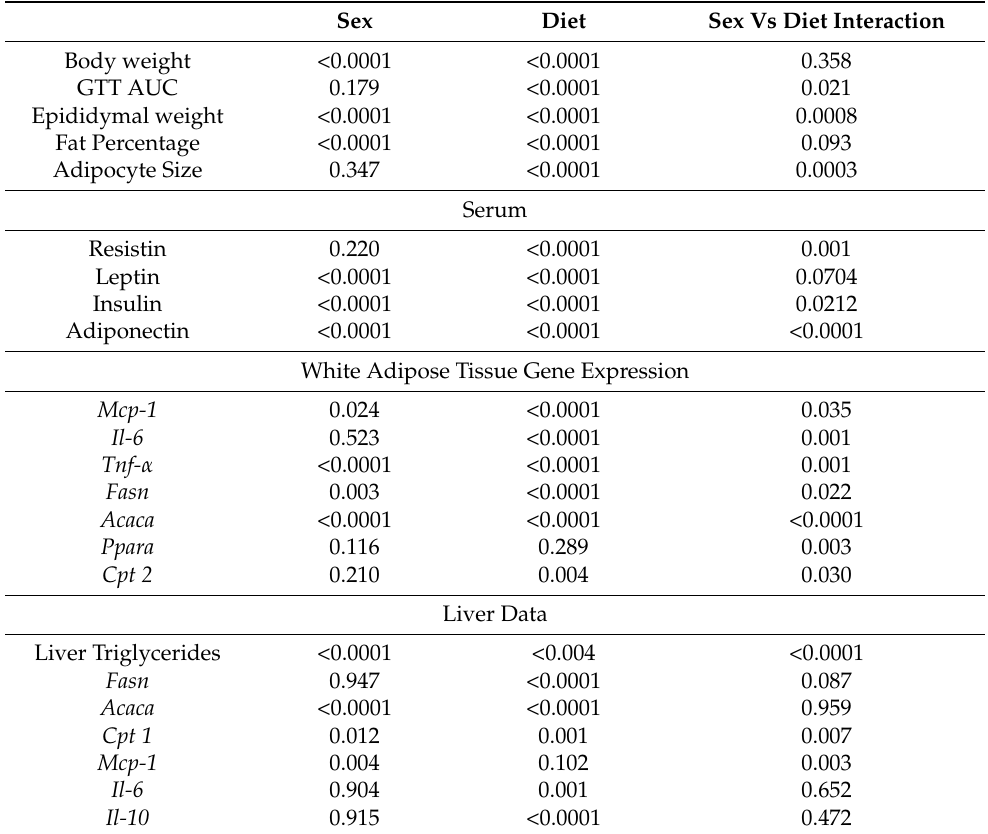
Table 1. Diet and sex interaction across groups (2-Way